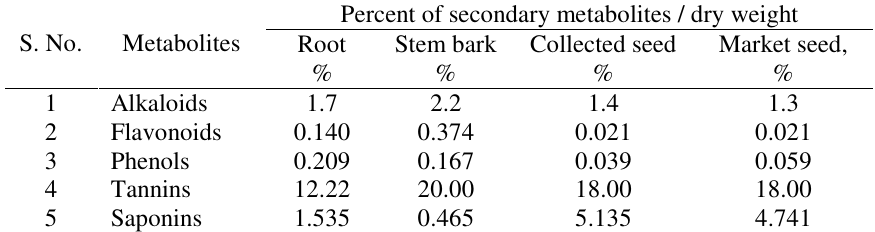
Table 2. Quantitative estimation of phytochemicals of S.potatorum S. No.